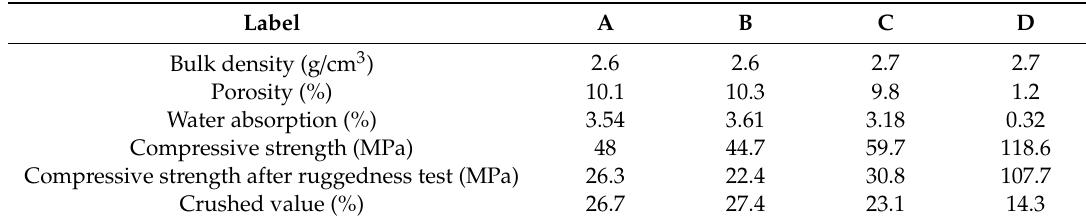
Table 2. The properties of the coarse